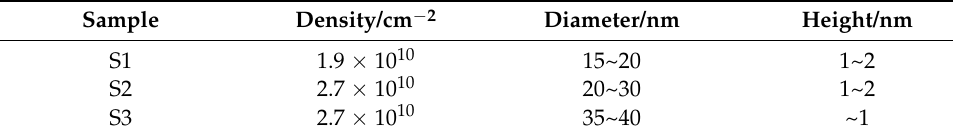
Table 2. Characteristics of QD-like centers in samples S1, S2, and S3.